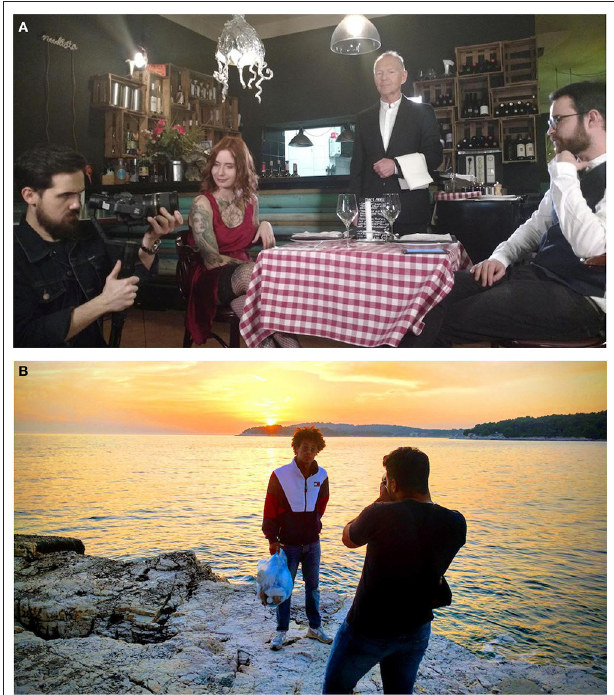
FIGURE 1 | Impressions from the production of the videos for (A) NiksDa and (B) dillan white showing the variance in setting, staging and presentation style used within the different contributions to the #EarthOvershootDay campaign (Photos: Nikolas Kappe, MESH